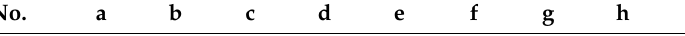
Figure 6. Raman spectroscopy of GO and RGO ( a : GO; b : ORGO at 35 ◦ C, 0.5 h; c : ORGO at 35 ◦ C, 5 h; d : ORGO at 50 ◦ C, 0.5 h; e : ORGO at 50 ◦ C, 5 h; f : ORGO at 80 ◦ C, 0.5 h; g : ORGO at 80 ◦ C, 5 h; h : ORGO at 120 ◦ C, 0.5 h; i : ORGO at 120 ◦ C, 5 h). Table 3. Fitting parameters describing the I D /I G for the ORGO shown in Figure 5.